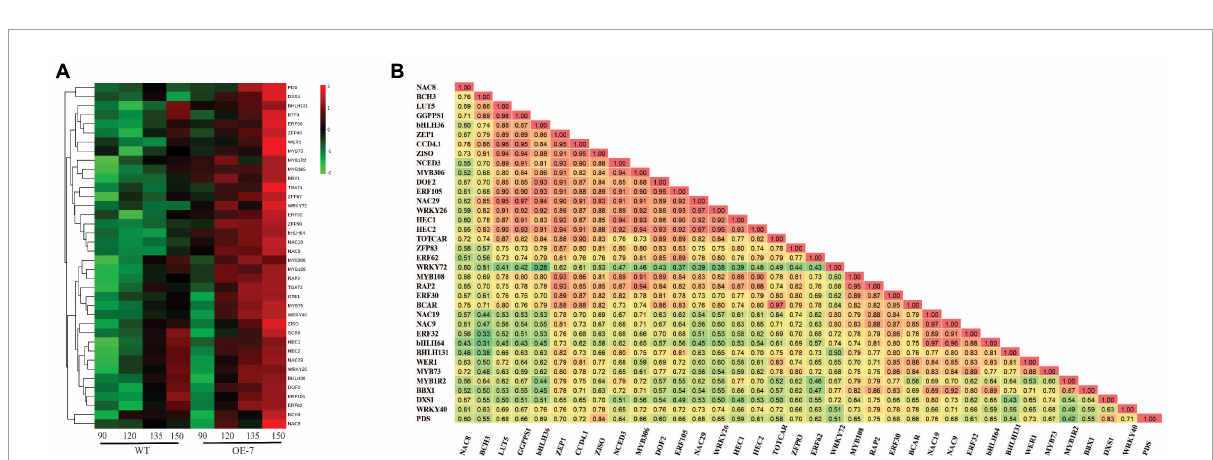
FIGURE5 Analysis of carotenoid-associated transcription factor genes. (A) Heat map of differentially expressed transcription factor genes ( Supplementary Table S4 ) in apple fruit flesh during development. The average gene expression of biological replicates at each of the four stages: 90, 120, 135, and 150 D, from WT and PSY transgenic line OE-7, were clustered using Euclidean distance relationships. Green to red color gradient indicates low to high relative gene expression. (B) Correlation matrix of gene transcripts and carotenoid metabolites ( β -carotene, BCAR; total carotenoid content, TOTCAR) in transgenic PSY fruit. Values represent correlation coefficients with color gradient from green to red indicating weak to strong correlations at P <